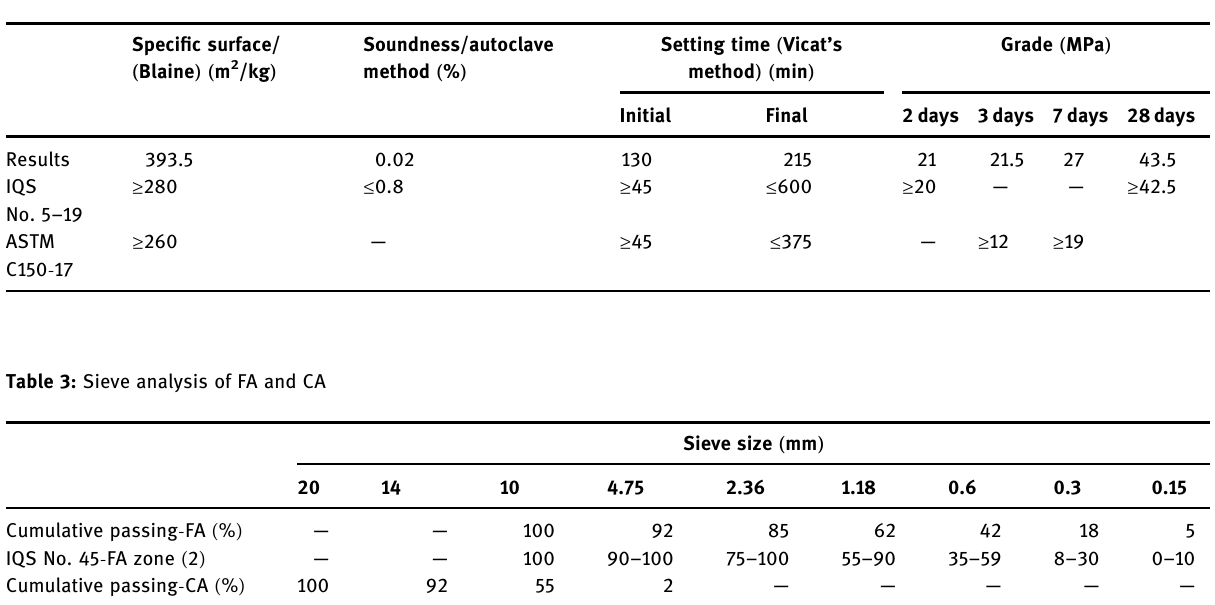
Table 2: Physical properties of OPC